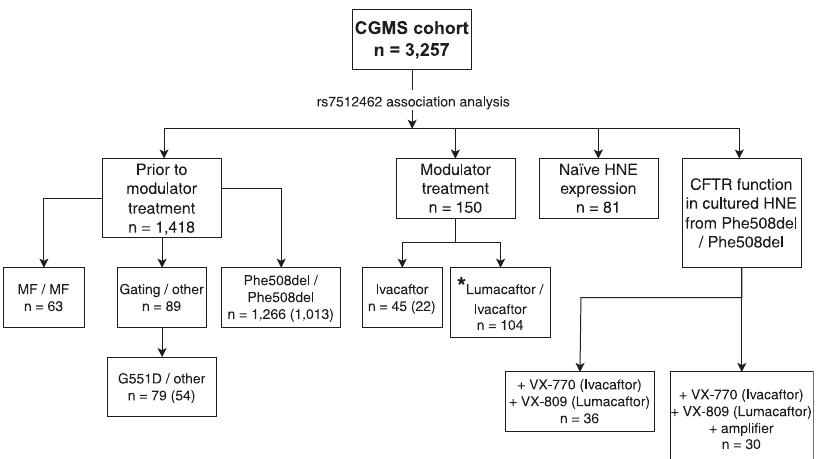
Fig. 1 Assessment of the association of rs7512462 in the Canadian CF Gene Modi fi er Study (CGMS) population broken down according to particular sub-study groups. Sample sizes indicated in parentheses represent the overlap with those published in Strug et al. 31 . MF minimal function variants; HNE human nasal epithelial. *This analysis is combined with the US PROSPECT